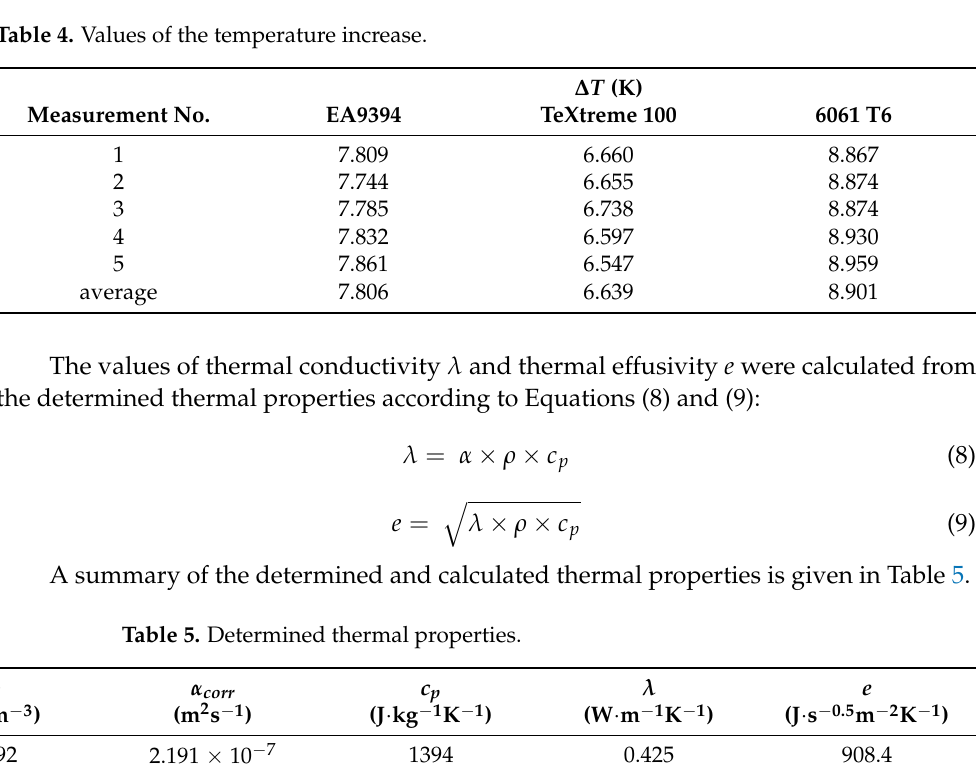
Table 4. Values of the temperature increase. Measurement No.